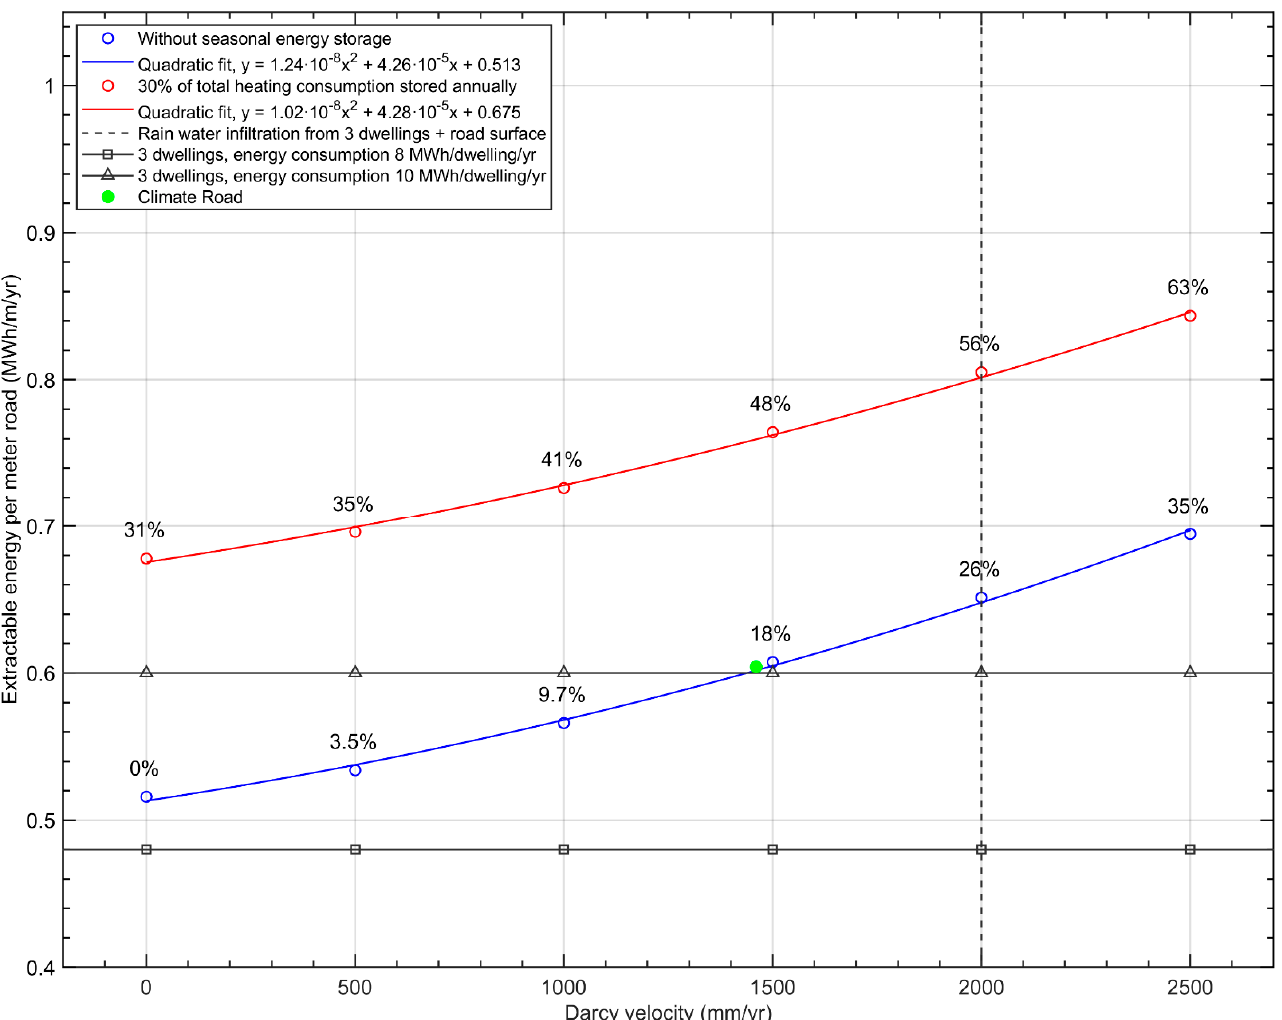
Figure 14. Estimated extractable energy for different infiltration rates and seasonal energy storage. Percentages are relative to the reference case indicated by 0% (zero infiltration, no seasonal energy storage).